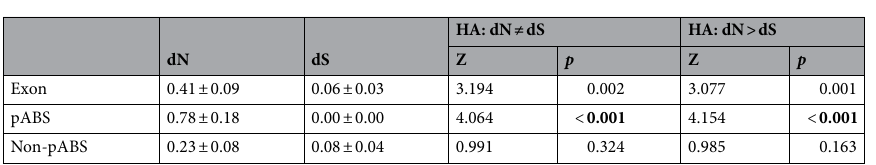
Table 1. Non-synonymous (dN) and synonymous (dS) substitution rates at the MHC class II DQB exon 2. p -values highlighted in bold indicate significant Z-statistics supporting the tested hypotheses based on modified Nei–Gojobori models with Jukes-Cantor correction. pABS putative antigen binding